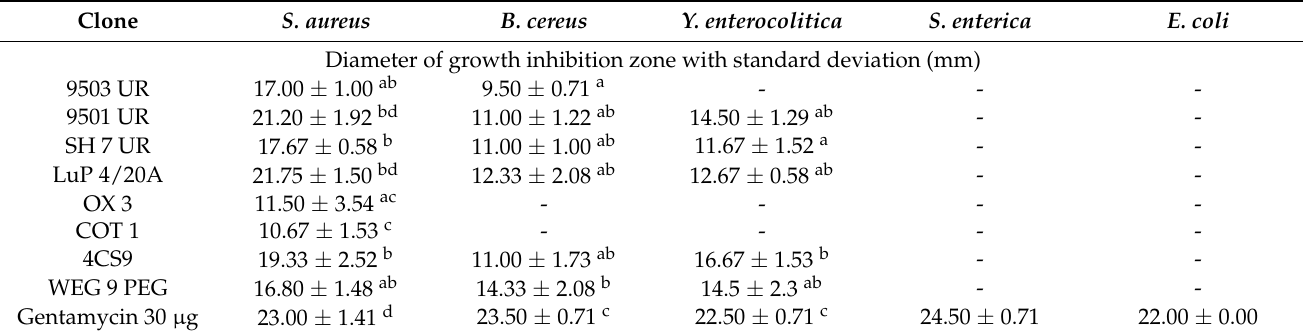
Table 4. Antibacterial properties of paulownia extracts determined by agar well diffusion method.